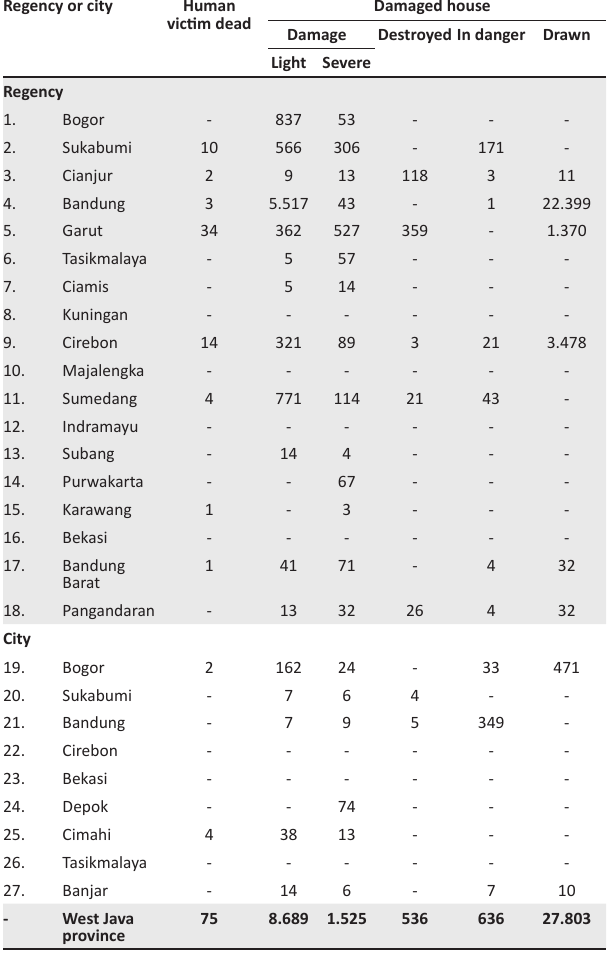
TABLE 3 : Total losses because of natural hazards by type in West Java, 2016. Regency or city